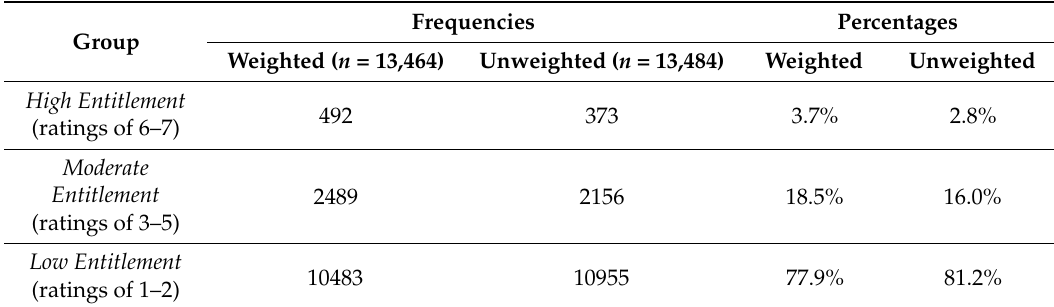
Table 1. Frequencies and percentages of participants within each antibiotic entitlement